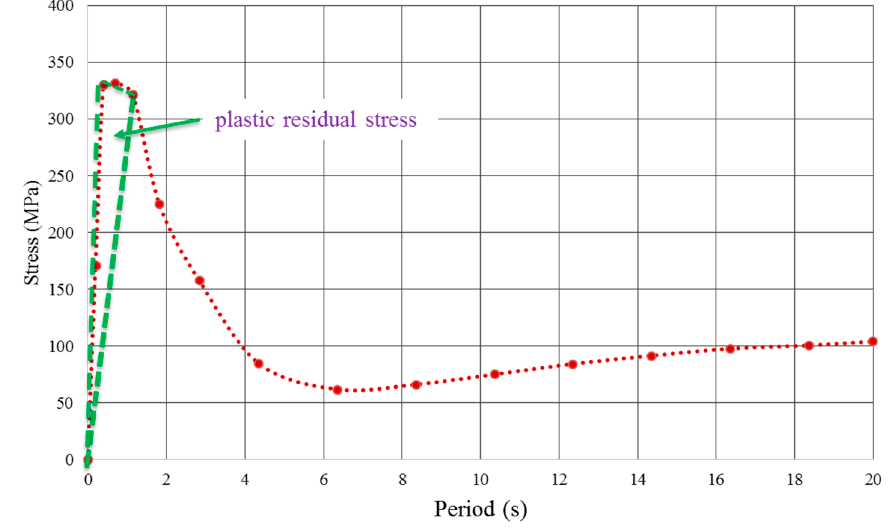
Figure 13. Stress history over time as a result of an impact wave due to an MCL earthquake.